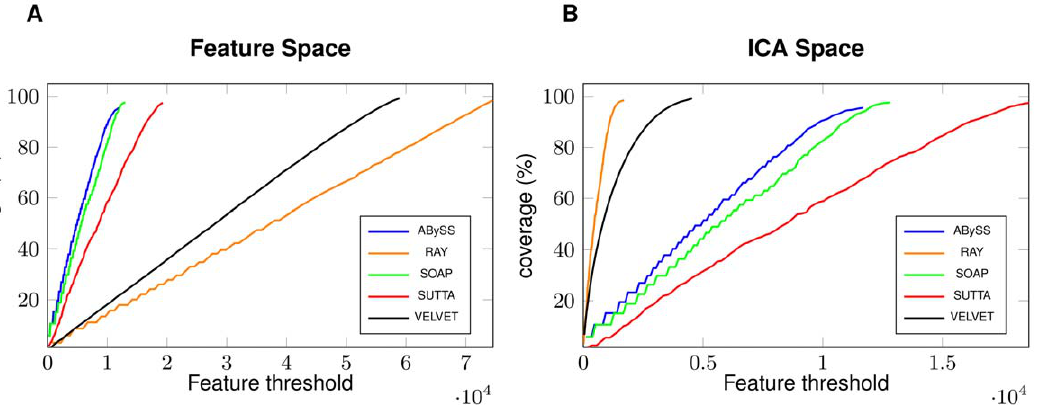
Figure 4. Feature Response Curve and ICA features: Real Short Reads. Figure A shows the FRC for the 5 assemblers on E. coli real dataset (read length 36 bp, insert size 200 bp and coverage 130 | ) when using all the feature space. Figure B shows the FRC computed on the ICA-selected features.